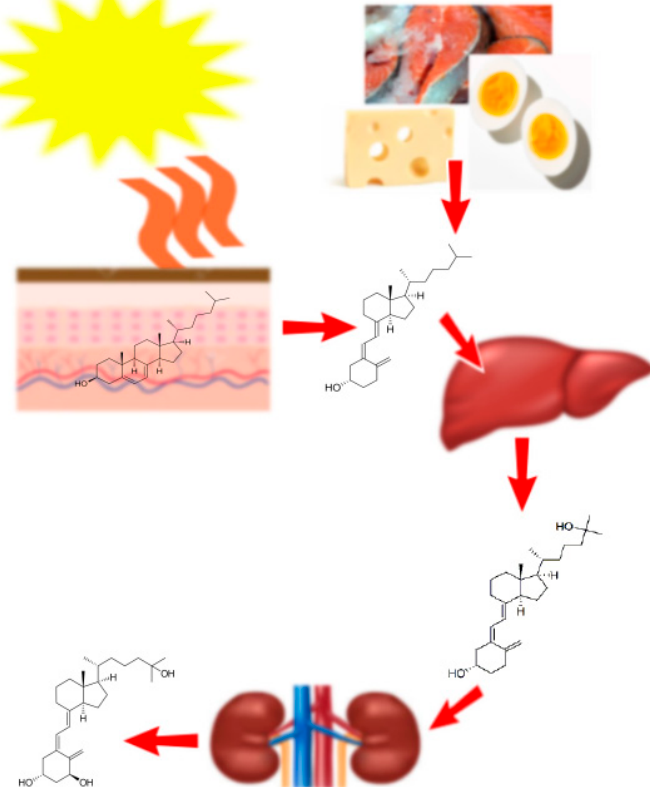
Figure 1. Outline of vitamin D metabolism. After exposure to sun, vitamin D is synthesized in the skin from 7-dehydrocholesterol. Alternatively, vitamin D may be obtained from diet. Vitamin D is converted to 25-hydroxyvitamin D in the liver, and then to 1,25-dihydroxyvitamin D in the kidneys. Double hydroxylated vitamin D, 1,25-dihydroxyvitamin D (1,25D), is a highly active